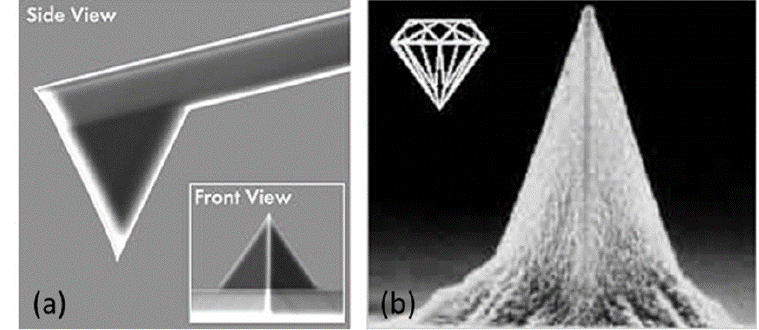
Figure 3. ( a ) AFM Si 3 N 4 tip with Cantilever and ( b ) diamond coated AFM tip, adapted from [109]. Reproduction with permission of Nanomonde Co. ( USA